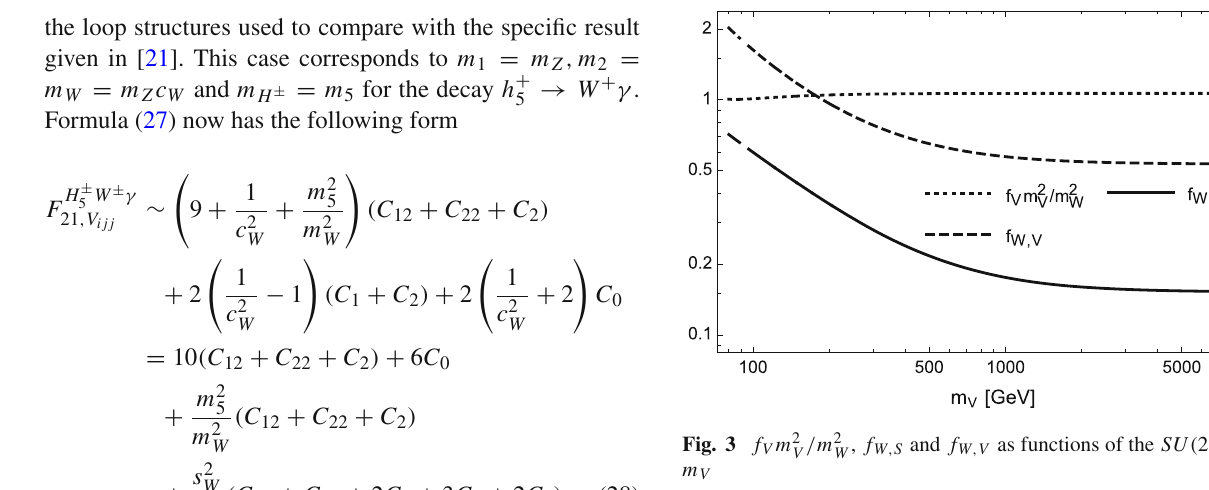
Fig. 3 f V m 2 m V